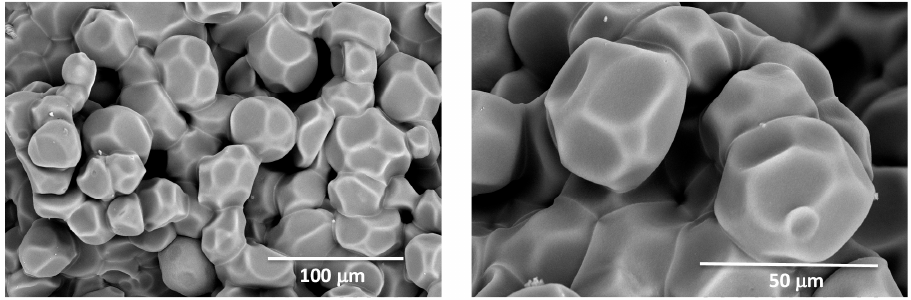
Figure 1. Scanning electron microscopy (SEM) pictures of glyoxal agarose beads: ( Left ) 400×; ( Right ) 1000×.